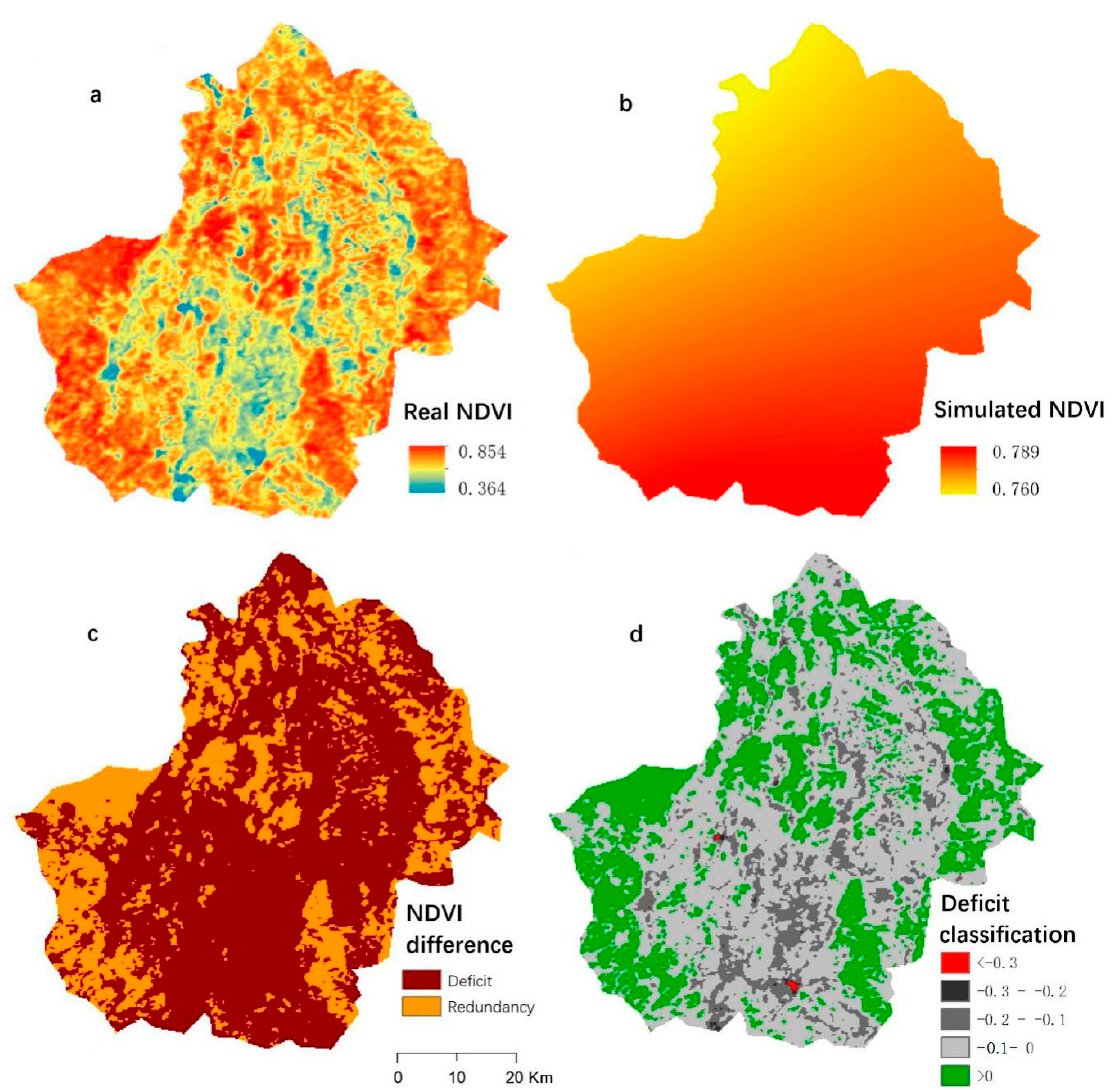
Figure 6. Spatial distribution of potential vegetation. ( a ) is the real vegetational NDVI in 2015; ( b ) is the simulated vegeta- tional NDVI; ( c ) is the differences between ( a ) and ( b ); ( d ) is the classification of vegetation deficit.